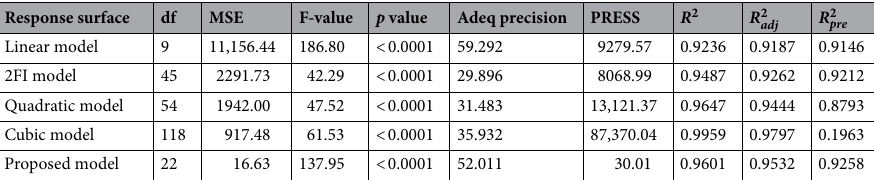
Table 4. Evaluation criteria for investigated and proposed regression